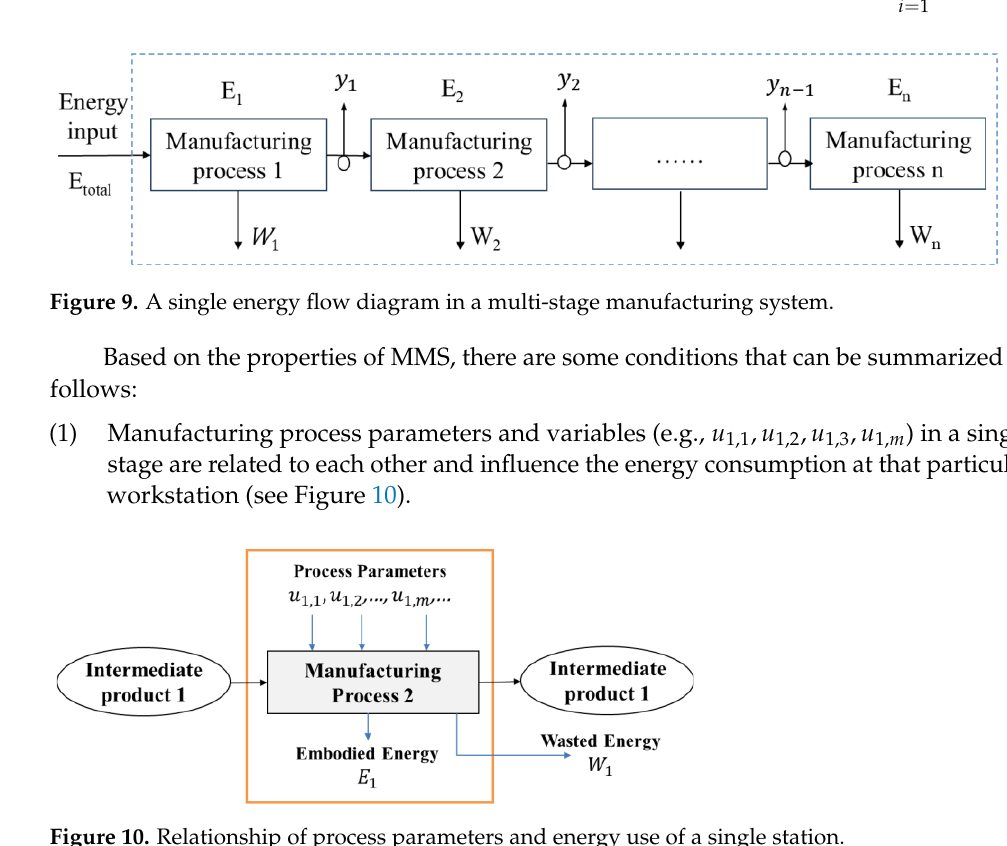
Figure 10. Relationship of process parameters and energy use of a single station.